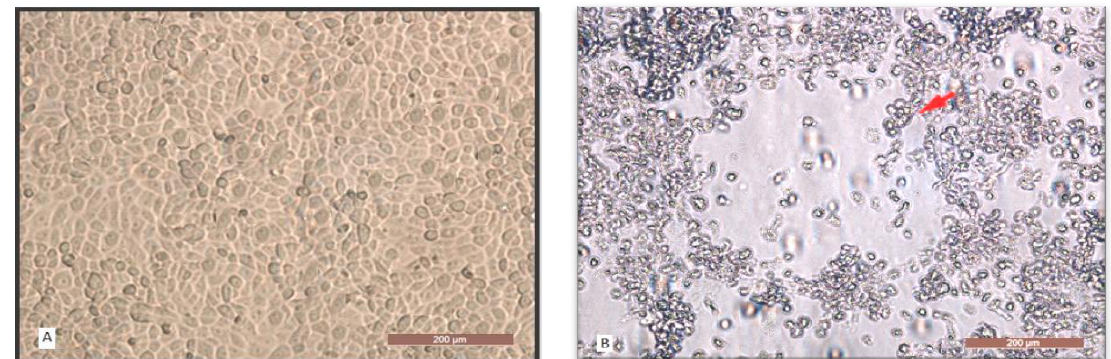
Figure, 1: (A) Uninfected control CAM cells monolayer. (B) Cytopathic effect of IBV isolate of the 3 rd passage at day 5 pi. The arrows show detachment of cells from the substrate with the eventual destruction of the entire monolayer. 10 x. Bar = 200 µm